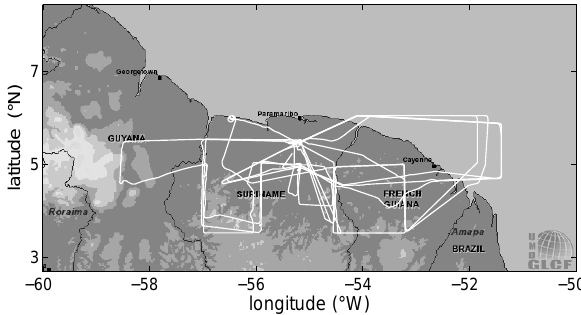
Fig. 1. Flight tracks over the Guyanas during the GABRIEL campaign (map taken from Earth Science Data Interface (ESDI), University of Maryland).